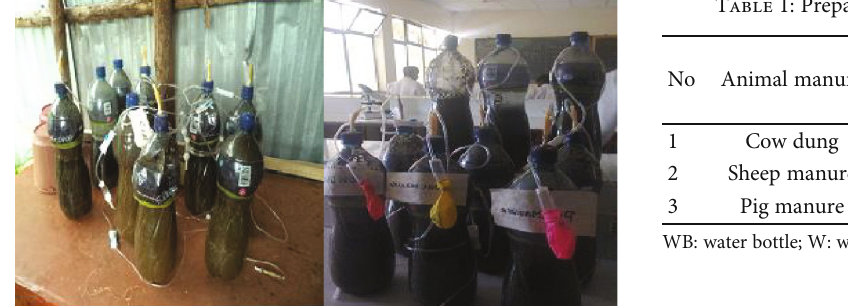
Figure 1: Experimental design and setup.